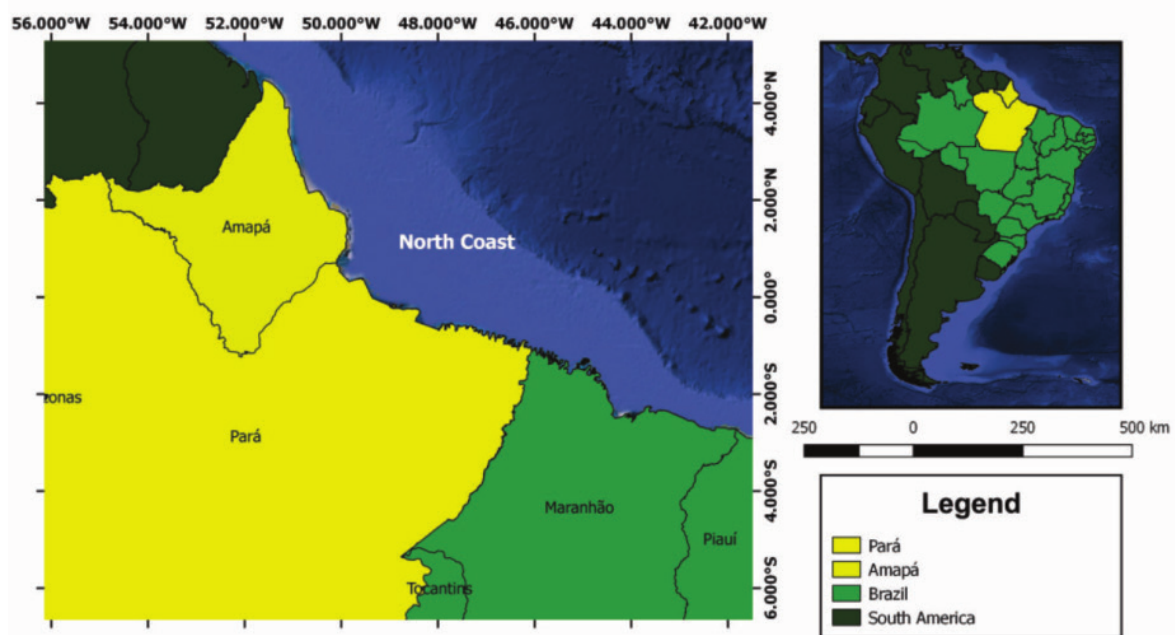
Figure 1. North Coast of Brazil (Amapá, Pará and Maranhão), highlighting the fishing area (Amapá-Pará) of the industrial fleet that captures the “piramutaba” ( Brachyplatystoma vaillantii)